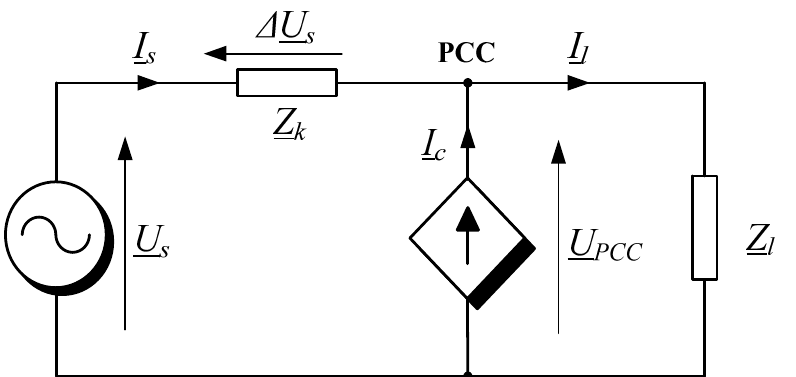
Figure 1. Simplified equivalent circuit of shunt active compensator installed in distribution line.